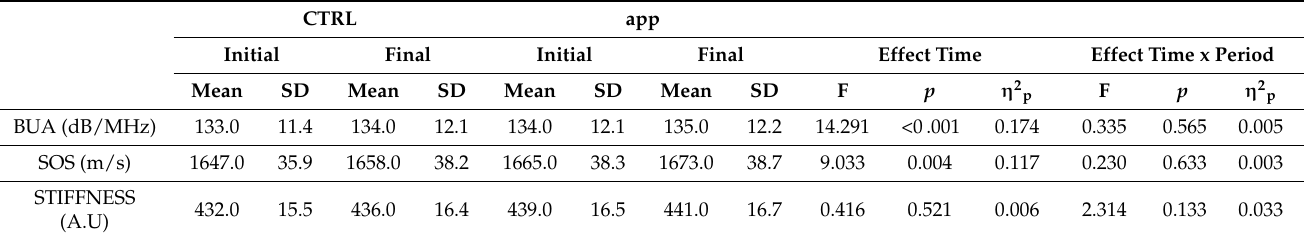
Table 6. Descriptive data (mean ± standard deviation) of quality bone variables. Effect of the intervention (ANOVA) on blood pressure